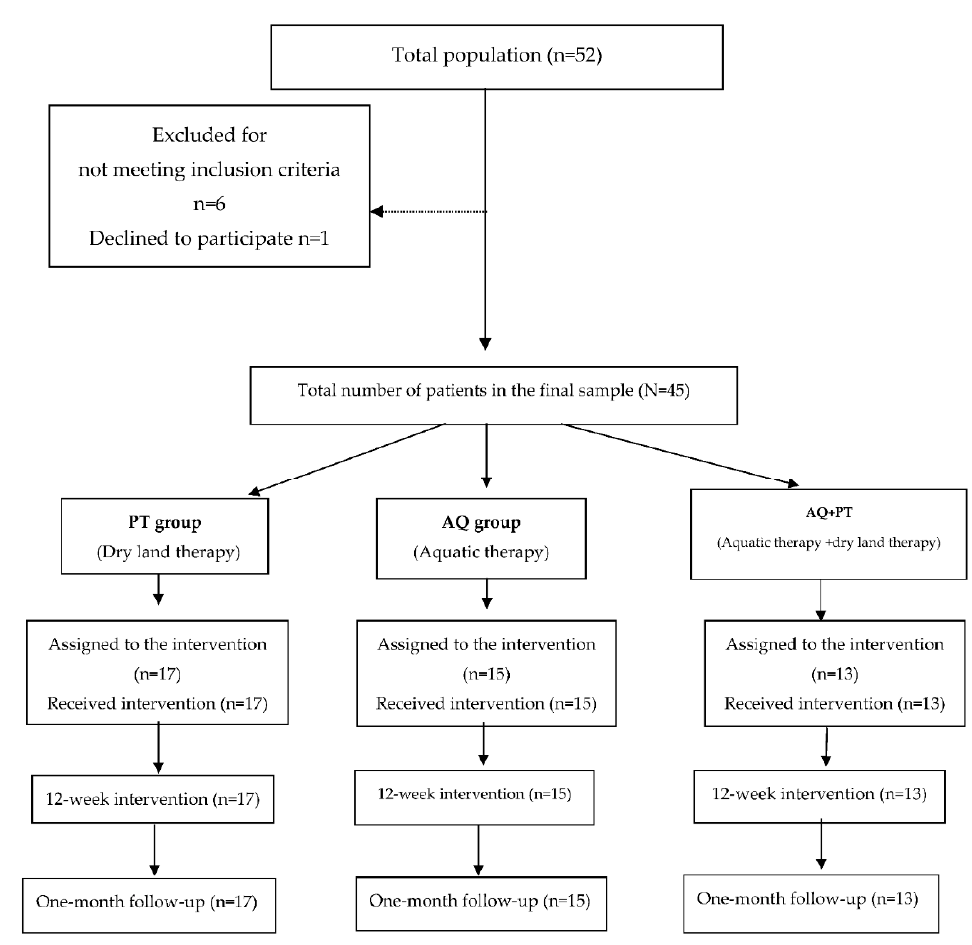
Figure 1. Study design flowchart.